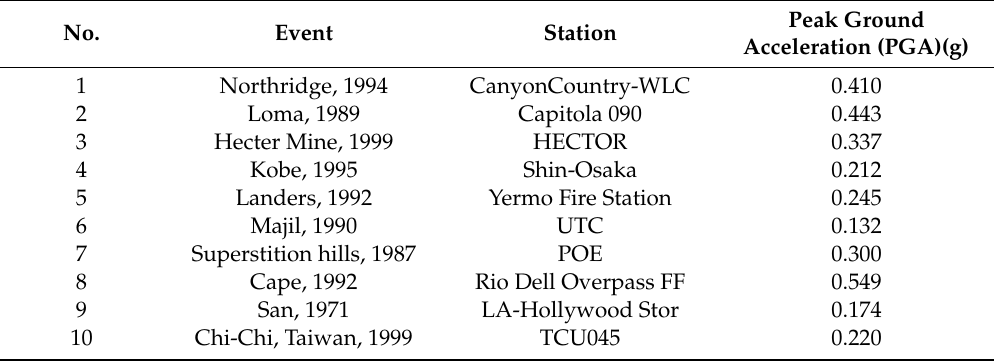
Table 1. The set of 10 ground motion records used.